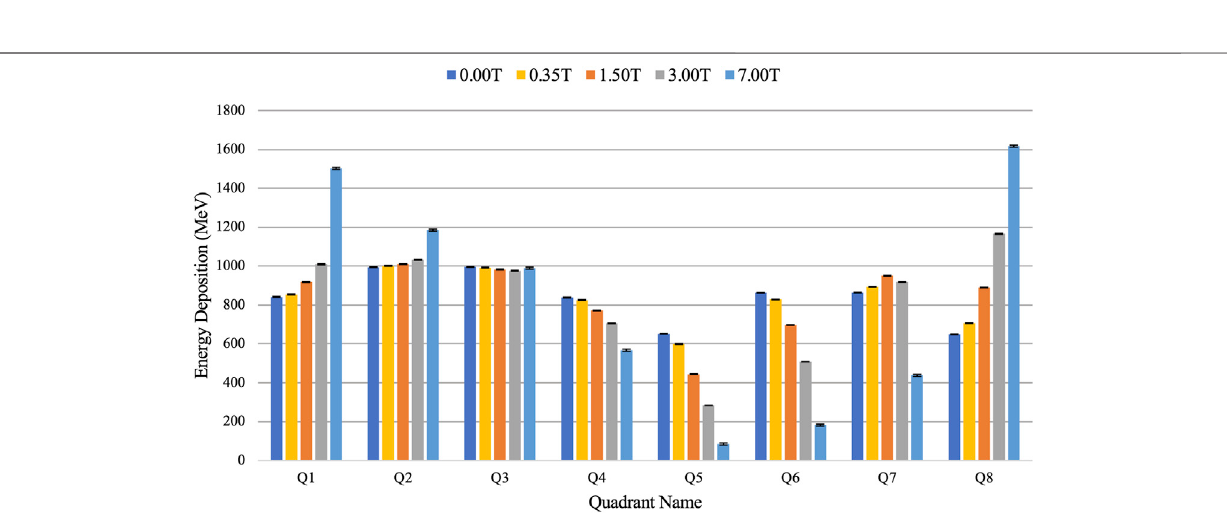
Frontiers in Physics |